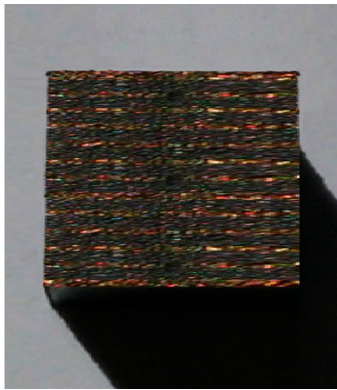
Figure 5. Metallographic specimen configuration of Ti-(SiC f /Al 3 Ti) CCFR-MIL composite.